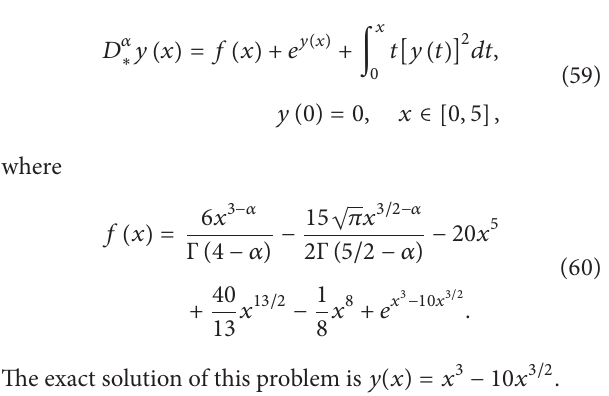
for 𝛼 = 0.90 and 𝛼 = 0.95 are also credible. Figure 1 also shows that as 𝛼 → 1 , the approximate solution tends to 𝑦(𝑥) = sin (𝑥) , which is the exact solution of this equation in the case 𝛼 = 1